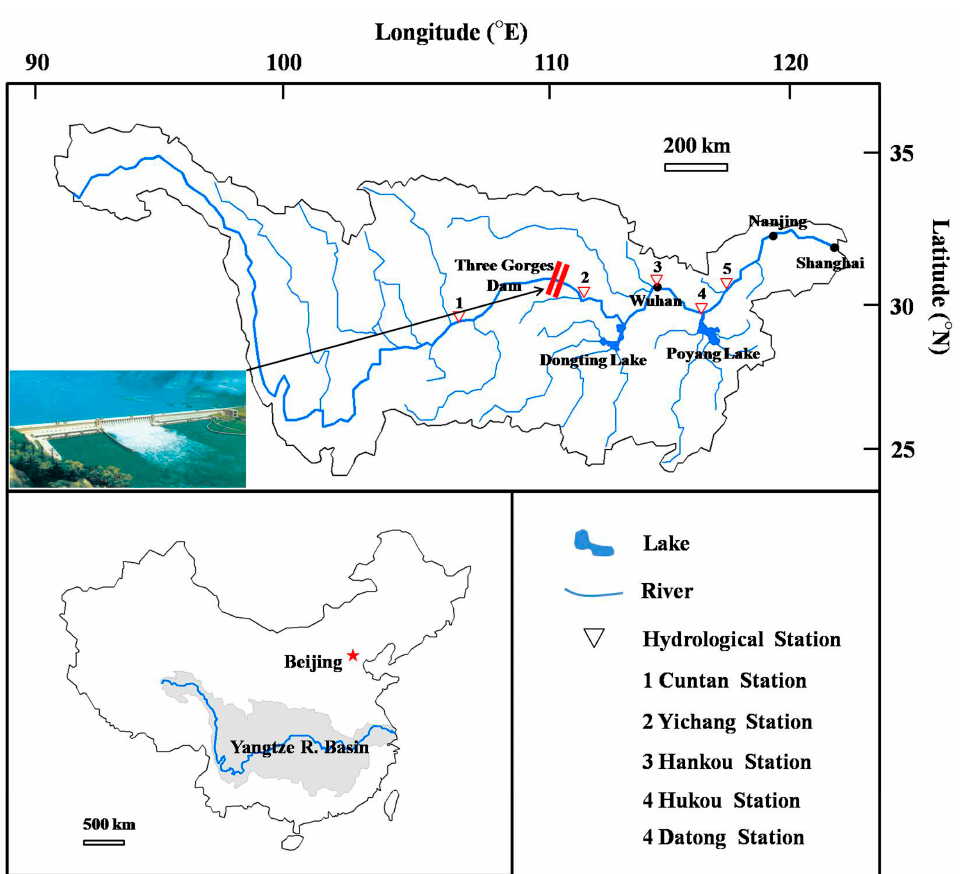
Figure 1. Location of the study region (Yangtze River Basin) and main hydrological gauging stations. Table 1. Hydrological settings of the mainstream of the Yangtze River. Upper (Above